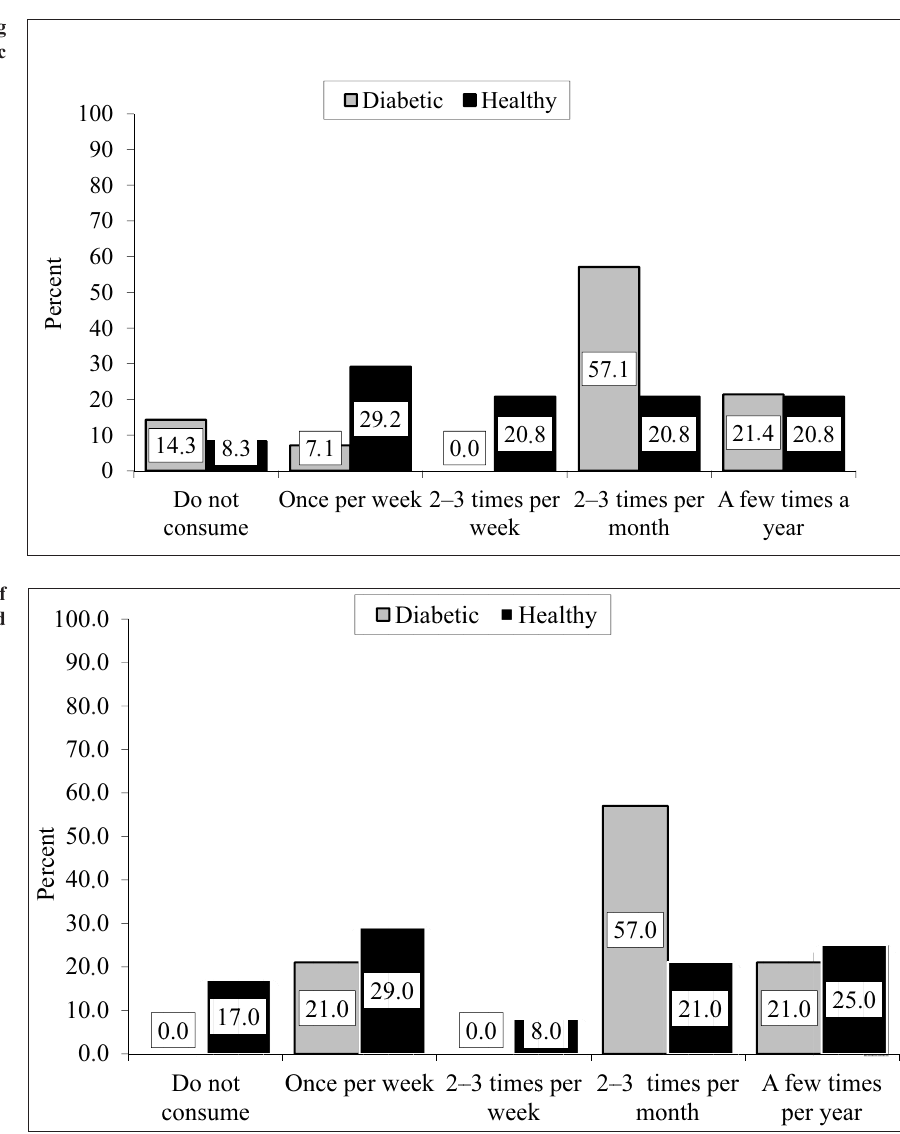
–Figure 7. Frequency of strong alcohol beverages in diabetic and control groups Figure